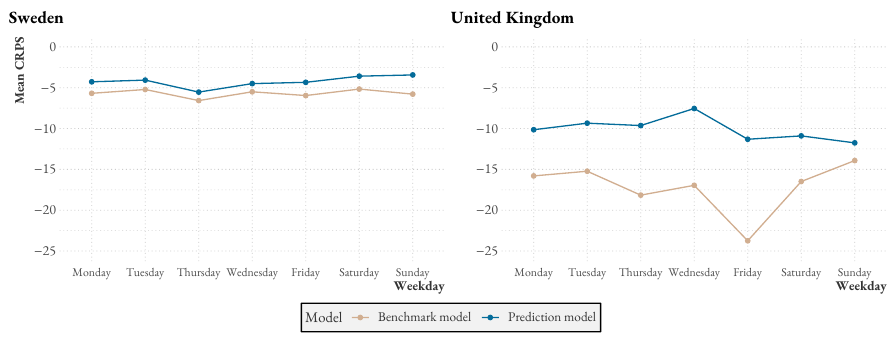
Figure A2. Mean CRPS per